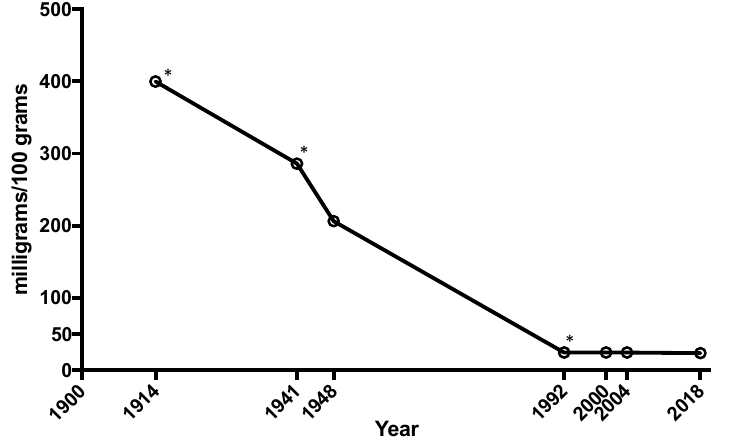
Figure 2. The average mineral content of calcium, magnesium, and iron in cabbage, lettuce, tomatoes, and spinach has dropped 80–90% between 1914 and 2018 [30,34–37]. Asterisks indicate numbers could not be independently verified.